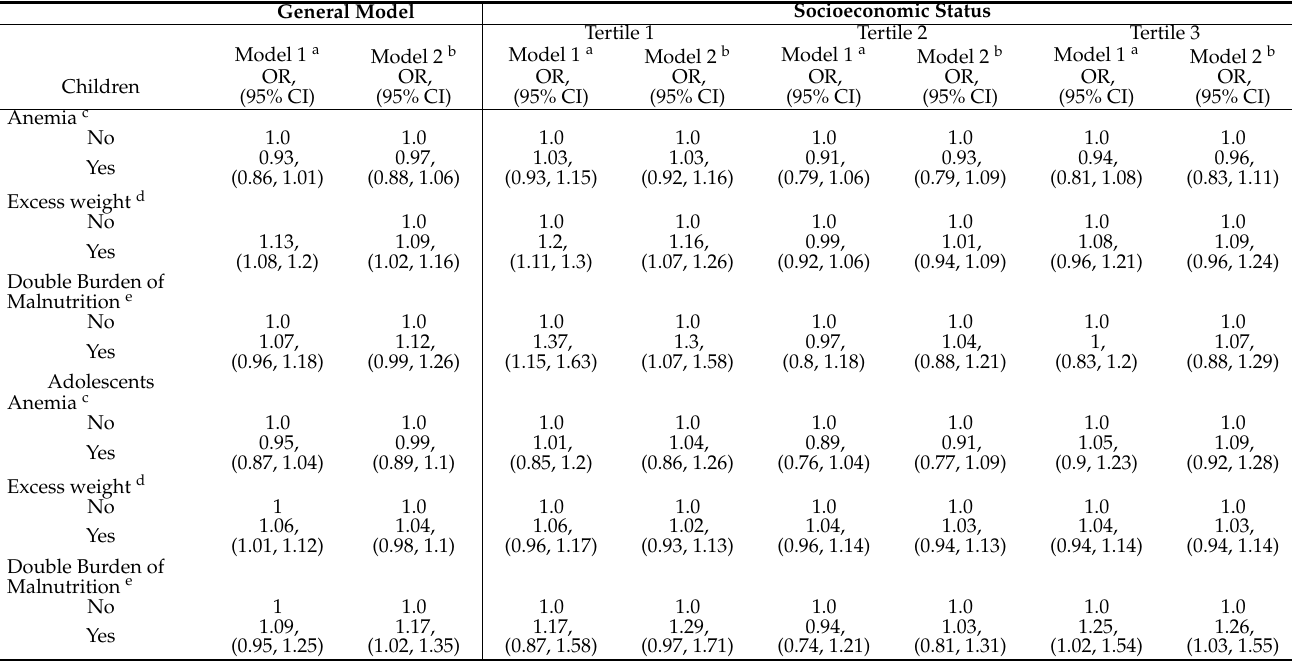
Table 2. Adjusted analyses of the association between the dietary intake of ultraprocessed products and health conditions in Mexican children and adolescents.